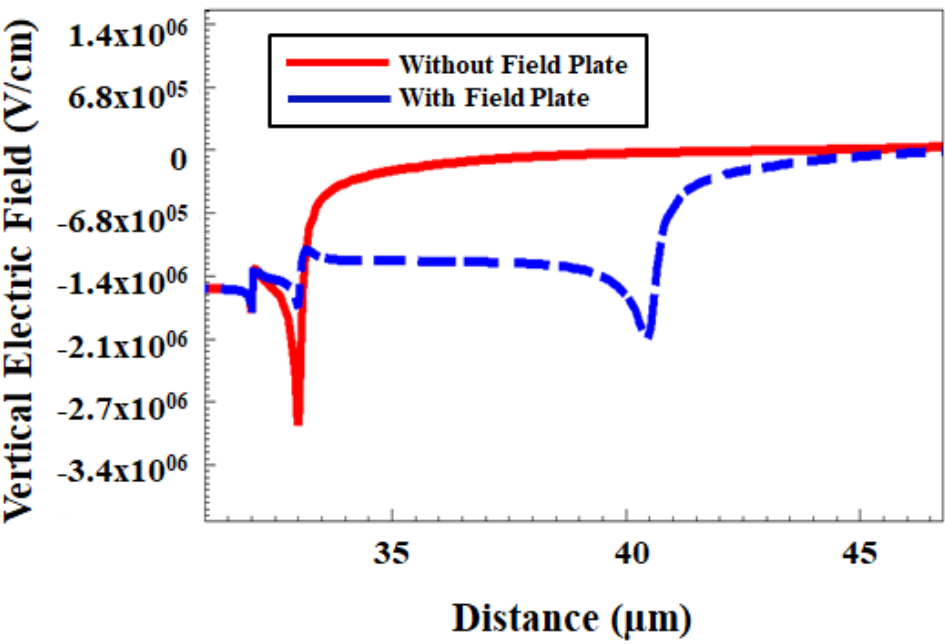
Figure 7. Simulated vertical electric field distribution with gate field plate and without gate field plate at 600 V breakdown voltage by drawing the cutline along X-axis in the 2DEG channel region.